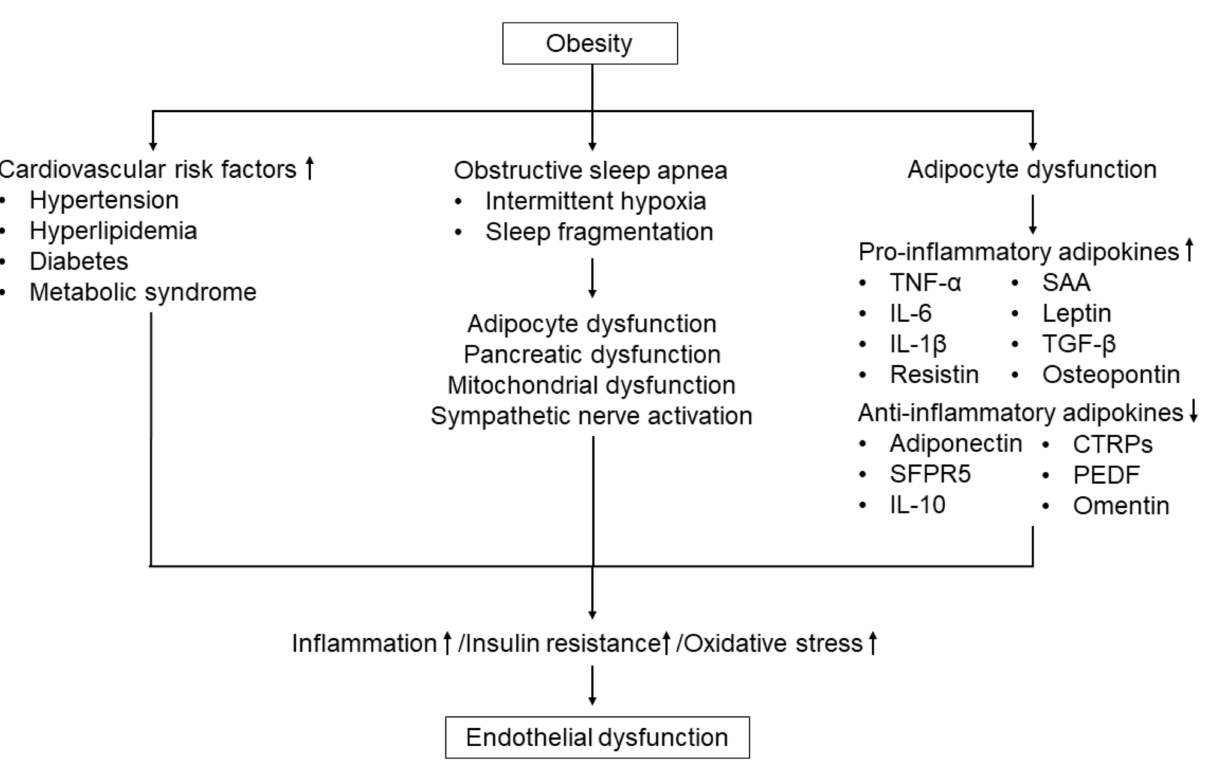
Figure 4. The putative mechanisms underlying endothelial dysfunction induced by